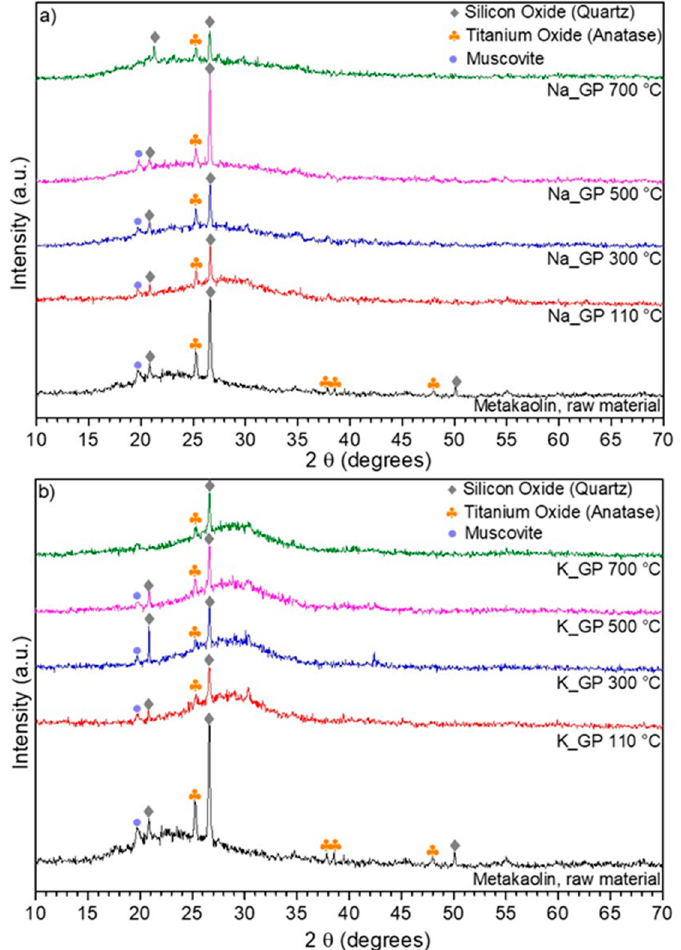
Figure 1. XRD patterns for metakaolin and geopolymer samples heat-treated at different temperatures: ( a ) Na-GP; ( b ) K-GP.